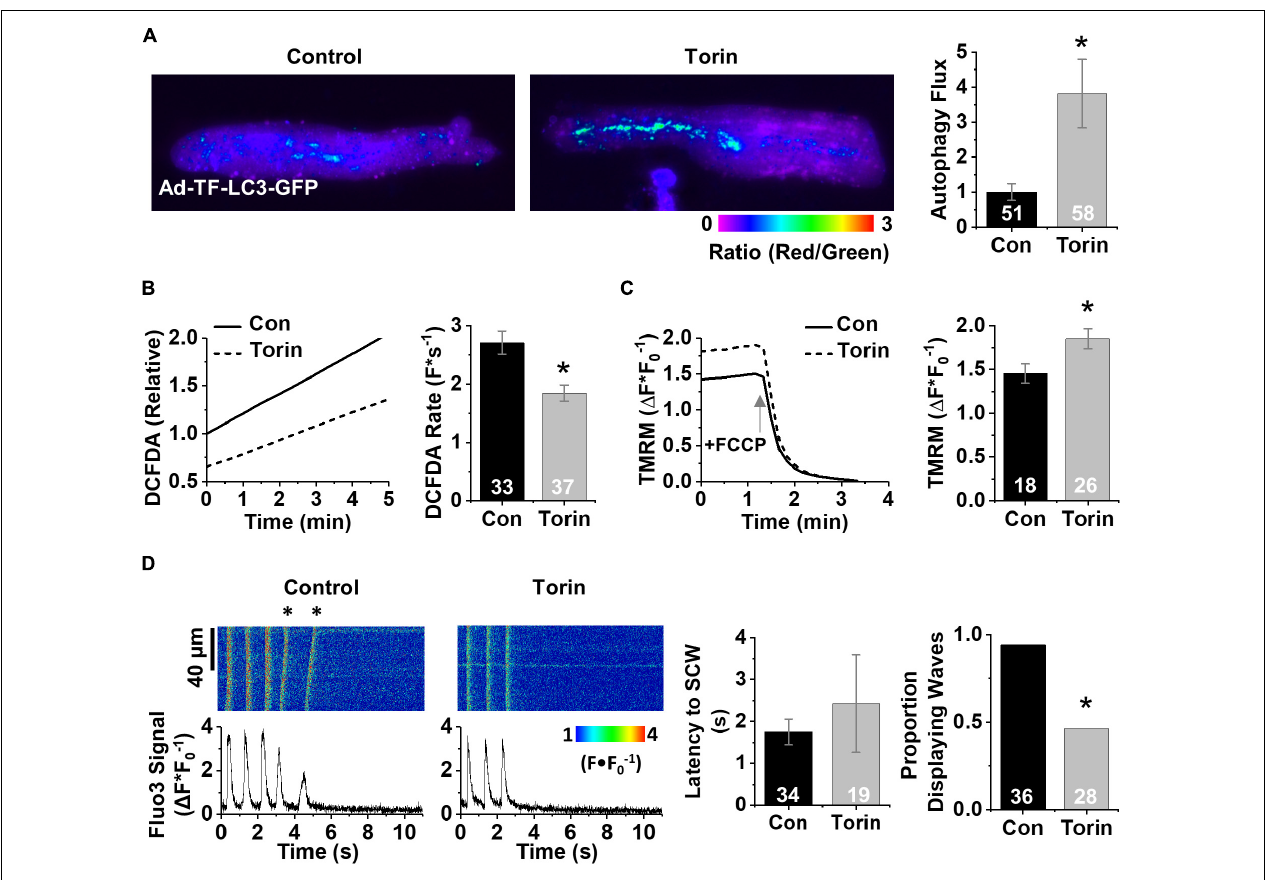
FIGURE 4 | Enhancing autophagy in aged rabbit CMs reduces ROS, restores (cid:49) ψ m, and reverses effects of aging on RyR2-mediated Ca 2 + release. (A) Fluorescence images of aged rabbit CMs treated with Torin1 visualizing autolysosomes as puncta. (B) Changes in DCFDA fluorescence in Torin1 and vehicle-treated aged rabbit CMs. Mean data represent ROS production rate. (C) Traces and mean data for normalized TMRM fluorescence of Torin1- and vehicle-treated CMs. Data are normalized to the minimum TMRM fluorescence in the presence of the uncoupling agent FCCP (50 µ M). (D) Confocal line scan images and Fluo3 profiles at the end of 30 s 1 Hz pacing train with aged rabbit CMs treated with Torin1 or vehicle; all with 25 nM isoproterenol. SCWs are indicated by an asterisk. Mean data for SCW latency and proportion of cells exhibiting SCWs (proportion data ∗ p < 0.05, Fisher’s exact test). ∗ p < 0.05, all values are mean ±